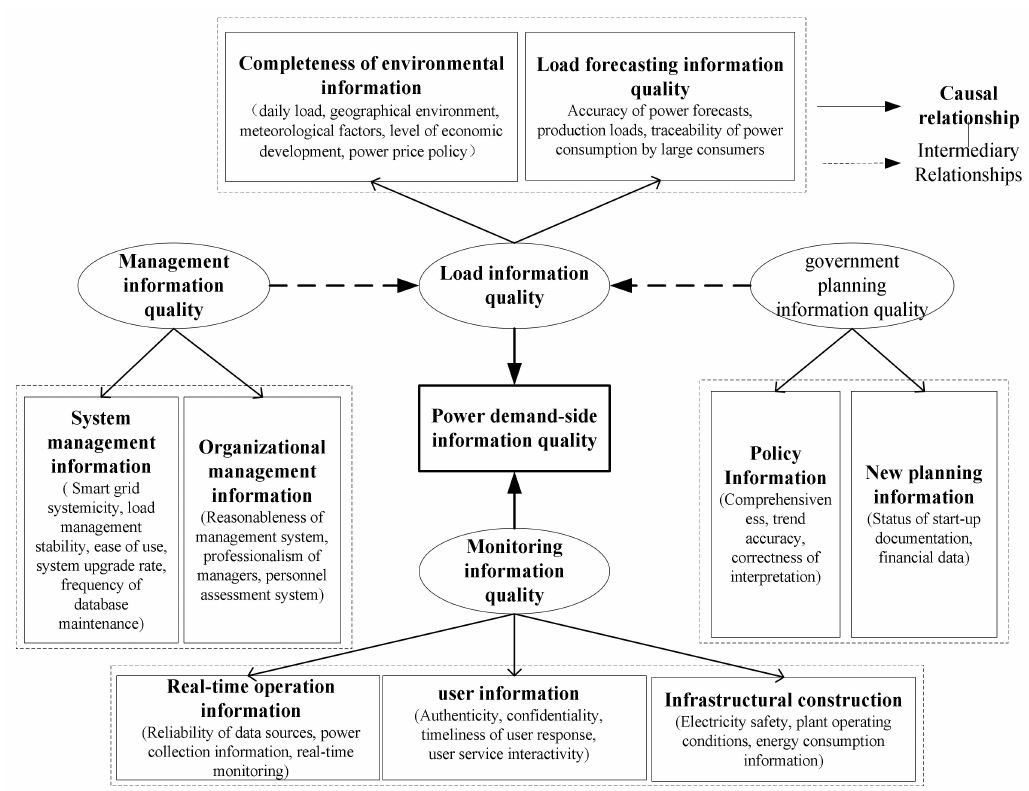
Figure 5. Relational structure model of influencing factors of power demand side information quality.